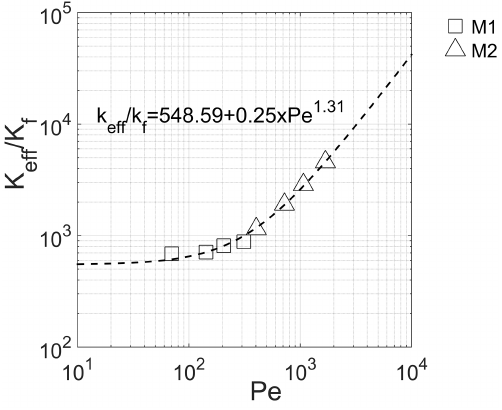
Figure 5. Relationship between Pe and k eff /k f .